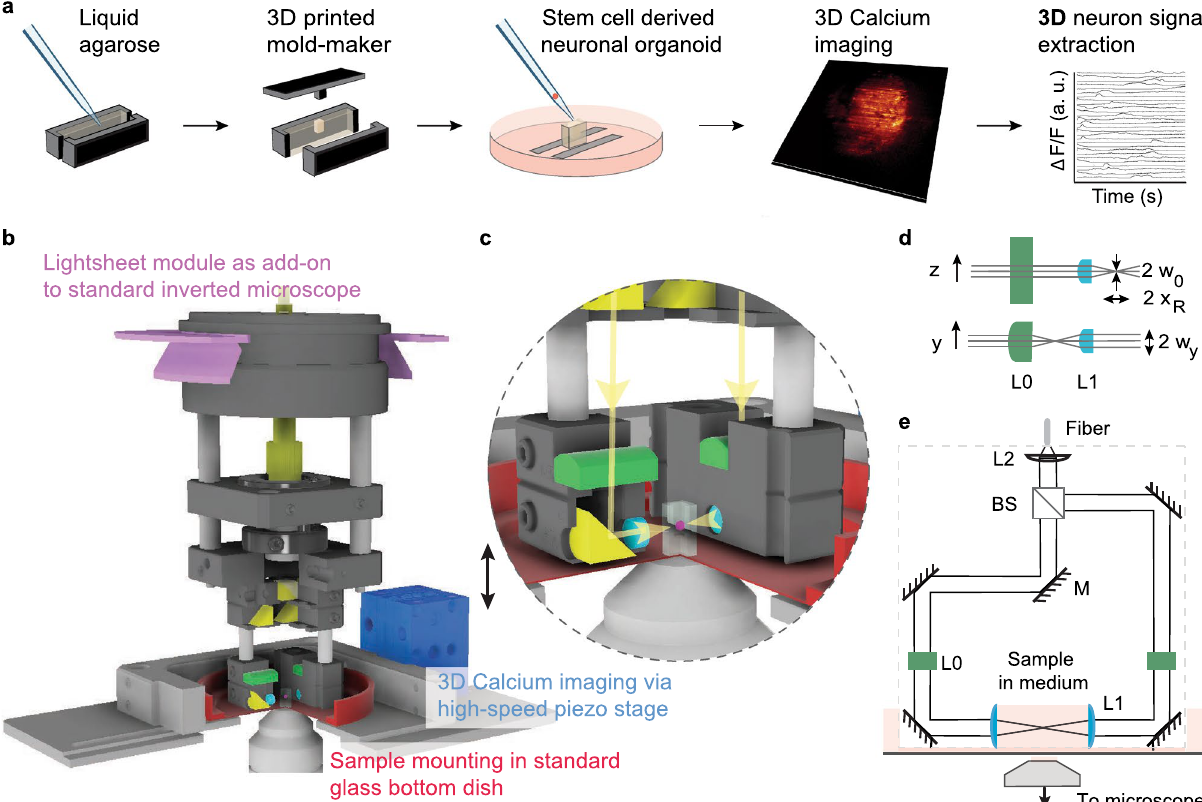
Figure 1. A minimal complexity light-sheet microscope enables fast volumetric imaging of neuronal signals. ( a ) Workflow for the extraction of 3D neuron signals. Temporal segmentation of neuron traces becomes possible via a custom pre-processing pipeline in combination with recent 3D neuron analysis software 44 . ( b , c ) The light- sheet module as an add-on to a standard inverted microscope. Volumetric imaging at single neuron resolution is achieved by movement of the sample along the optical axis using a high-speed piezo-stage (10 ms per plane or 5 volumes/s with 20 planes/volume). ( d , e ) Light-sheet optical path. The optical beam, delivered via a fiber, is split via a cube beam splitter and directed to the sample by right-angle prisms (M). A static planar light-sheet is created by focusing the beam via a cylindrical lens (L0) at the back focal plane of an aspherical lens currently limited by the rate of camera acquisition (100 fps). In contrast to other simplistic setups 39 , the sample is moved while the illumination and detection optics remain still. Due to the lower weight of the glass bottom dish compared to the objective, this, in principle, allows faster scanning. Subcellular optical resolution. To determine the microscope’s resolution, we characterized the light- sheet parameters and the system’s point spread function (PSF) (Fig. 2). The lateral 1/e resolution mainly depends on the numerical aperture of the objective. The axial resolution is predominantly influenced by the thickness of the anisotropic Gaussian beam light-sheet in case of the 20 × objective due to its finite optical sectioning capabili- ties (NA = 0.5). The Gaussian beam is parametrized by its beam waist w 0 which determines its thickness as 2 w 0 and its Rayleigh length x R = n π w 02 / (cid:31) with wavelength (cid:31) and refractive index n . Its lateral extension is given by its 1 / e 2 width w y . To quantify those parameters, we imaged the light-sheet’s transversal illumination profile by deflecting the light into the detection path using a 45 ◦ tilted mirror. Different planes along the propagation axis x were imaged by translating the mirror with respect to the light-sheet and the objective. Each image was fitted with a 2D Gaussian and w ( x ) and w y ( x ) was extracted. Fitting w ( x ) yields the light-sheet’s waist w 0 and its Rayleigh length x R (Fig. 2a–c). The characterization was performed for all three laser lines. The thickness of the light-sheet remains well below 10 microns and thus is comparable to typical light-sheet setups (Suppl. Table 1). The recorded chromatic focus shift is on the same order of magnitude as the Rayleigh length of the light-sheet beam, allowing simultaneous multicolor imaging (Fig. 2b) at decreased axial resolution (Suppl. Fig. S4). The light sheet dimensions are about a factor of 1.5 larger than the theoretical estimation. We suspect imperfection on the cylindrical lens as the cause as its surface roughness is not specified to < λ/4. To measure the 3D resolu- tion, we recorded the PSF by imaging gel-embedded 170 nm fluorescent beads (Fig. 2d). For each bead, we measured the lateral and the axial intensity profiles along two perpendicular axes in three central planes ( xy , xz , yz ) and fitted a Gaussian function. The 1 / e radius σ x , y , z was taken as the resolution measure yielding a lateral resolution of 0.9 µm (0.5 µm) and an axial resolution of 1.7 µm (1.1 µm) for the 20x (40x) objective, respectively.